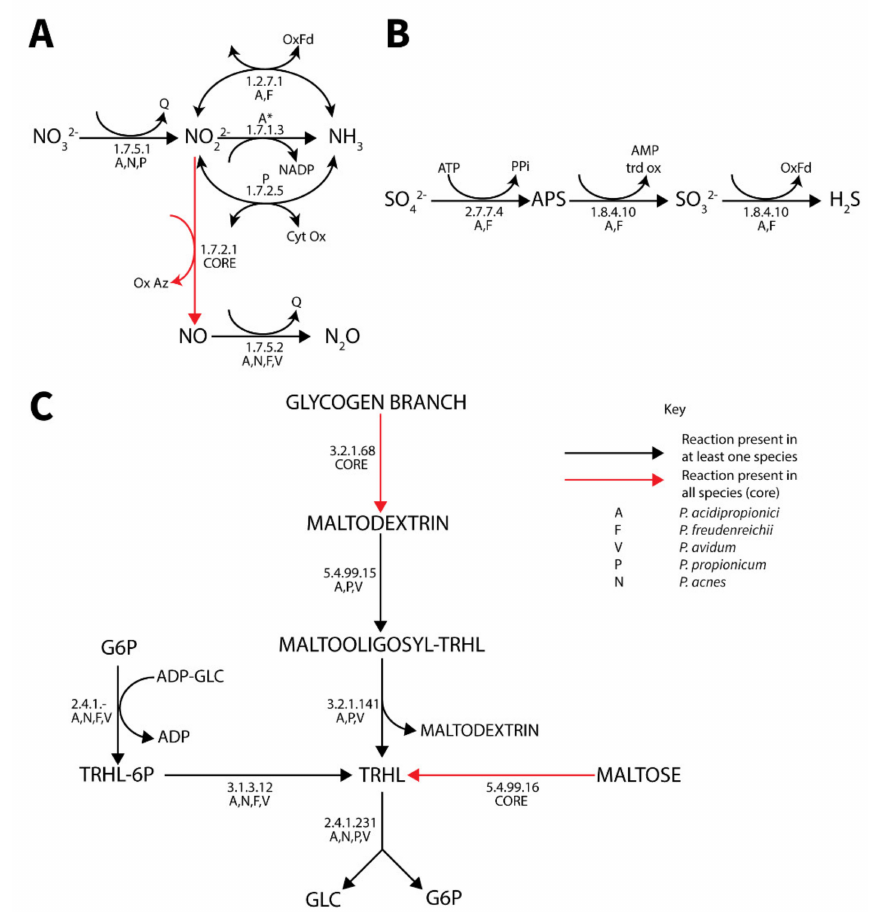
Figure 5. Diagrams of the pan-genomic nitrate ( A ), sulfate ( B ) and trehalose ( C ) metabolism in Propionibacterium . (Black) arrows represent reactions present in at least one species. (Red) arrows represent reaction in all species (core). *Enzyme is present in both P. acidipropionici strains but 4875 has a frameshift mutation likely rendering the enzyme